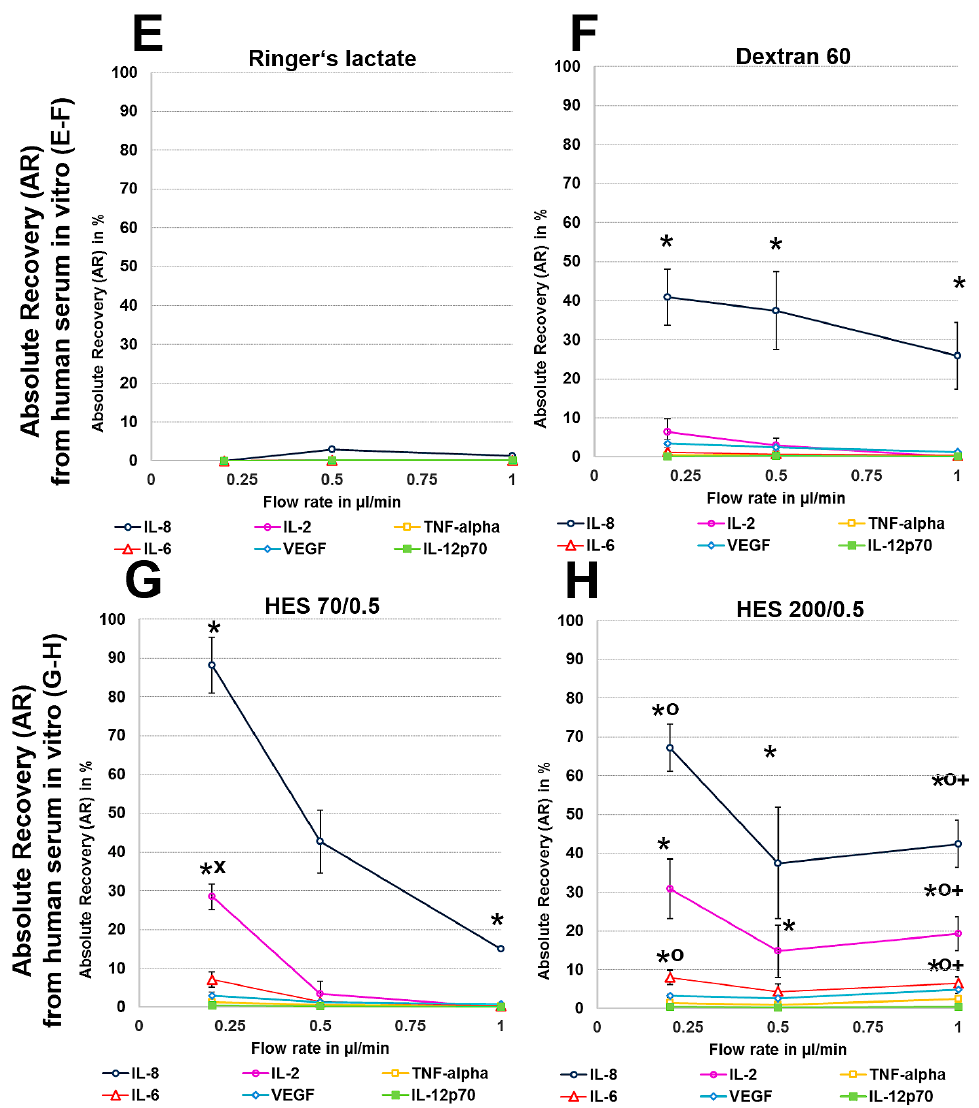
Figure 3. ( A – H ): Effect of different colloid perfusates (dextran 60 ( B , F ), hydroxyethyl starches (HES) 70/0.5 ( C , G ) and 200/0.5 ( D , H ) and the crystalloid Ringer’s lactate solution ( A , E )) on absolute recovery (AR) in Ringer’s lactate solution ( A – D ) and human serum ( E – H ) in vitro. Each figure represents the mean values with standard deviation of three independent experiments of all six cytokines at flow rates of 0.2, 0.5 and 1 µL/min. Significance ( p < 0.05) is indicated by *, x, o and +. * shows significant differences compared with Ringer’s lactate, x shows significant differences compared with HES 200/0.5, + shows significant differences compared with HES 70/0.5, and o shows significant differences compared with dextran 60 solution.